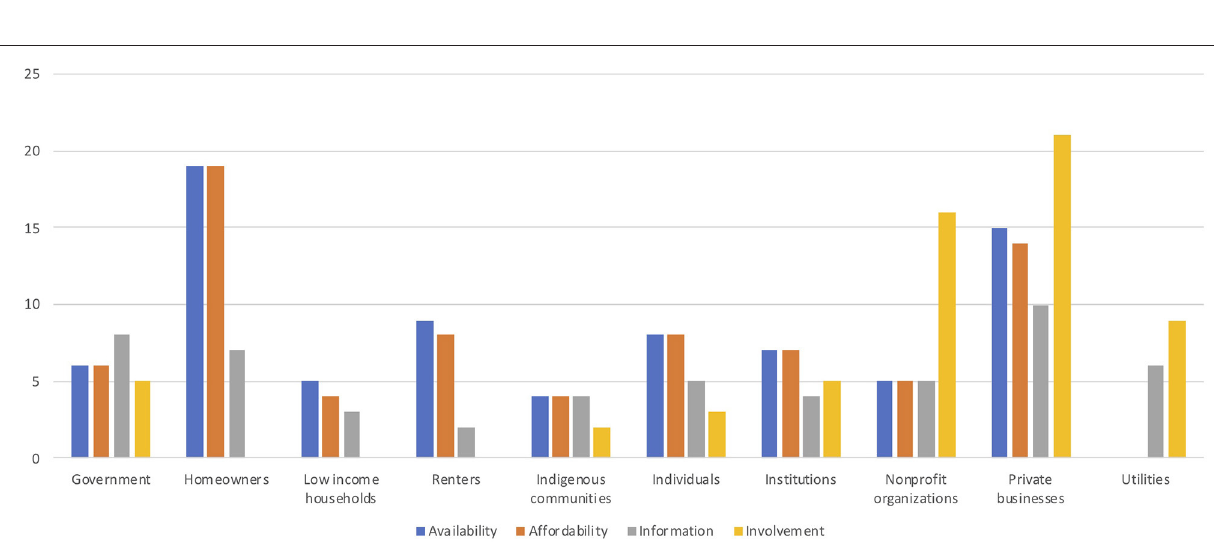
FIGURE 3 | Energy justice of utility provided innovations according to user type ( n =